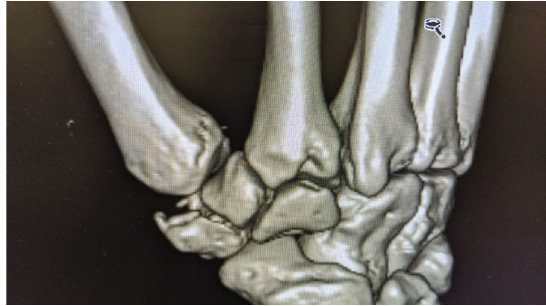
Figure 2: CT with 3D reconstruction detailing trapezium fracture.